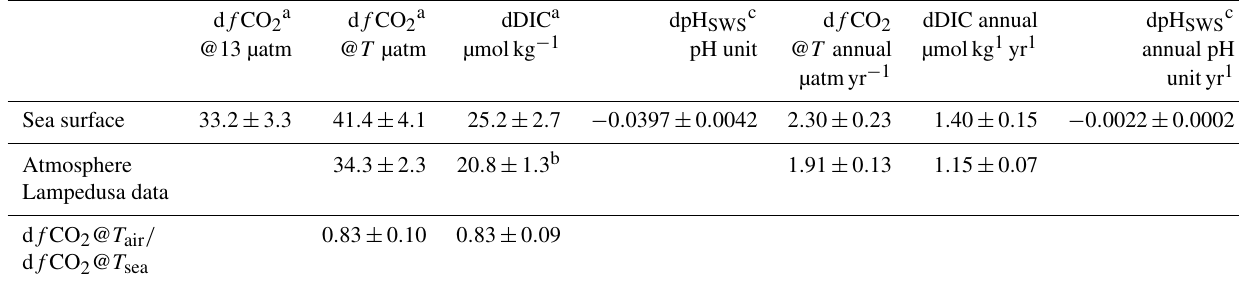
Table 2. Seasonally detrended long-term and annual trends of seawater carbonate chemistry and atmospheric composition. d f CO 2a d f CO 2a dDIC a